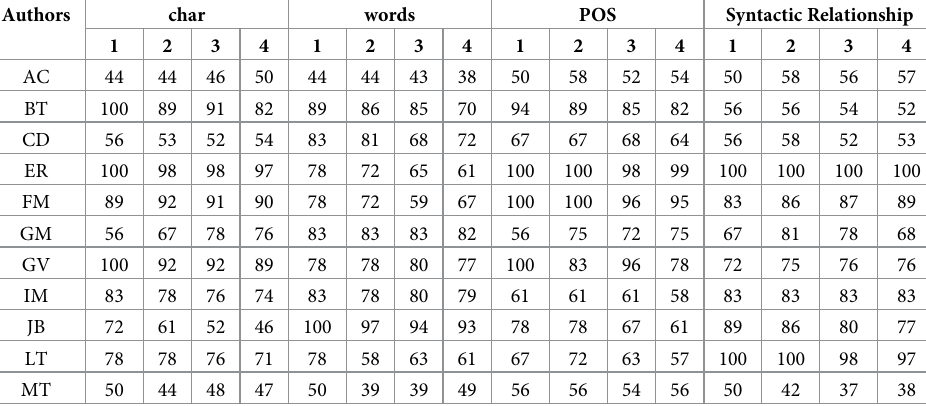
Table 9. Accuracy (%) using PCA-features (1, 2, 3, 4 are split settings).